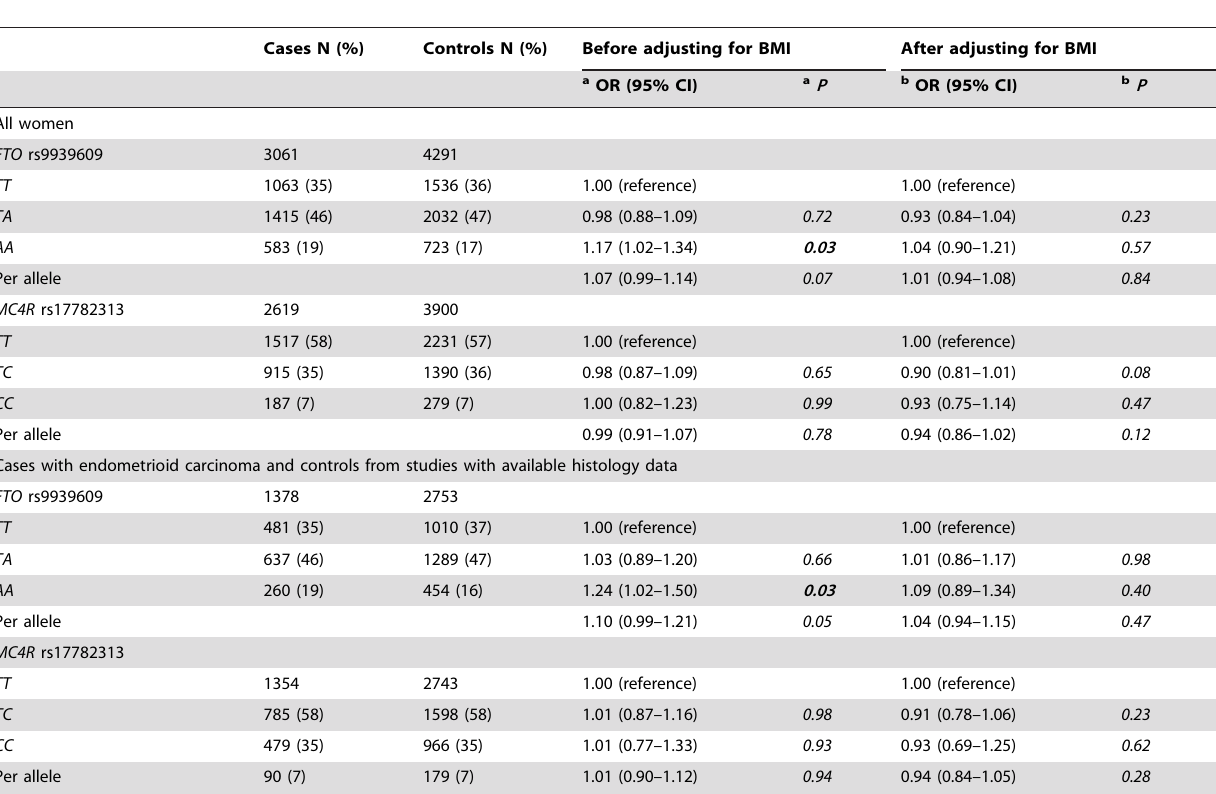
Table 3. Association of the FTO rs9939609 and MC4R rs17782313 with endometrial carcinoma risk among women with BMI data